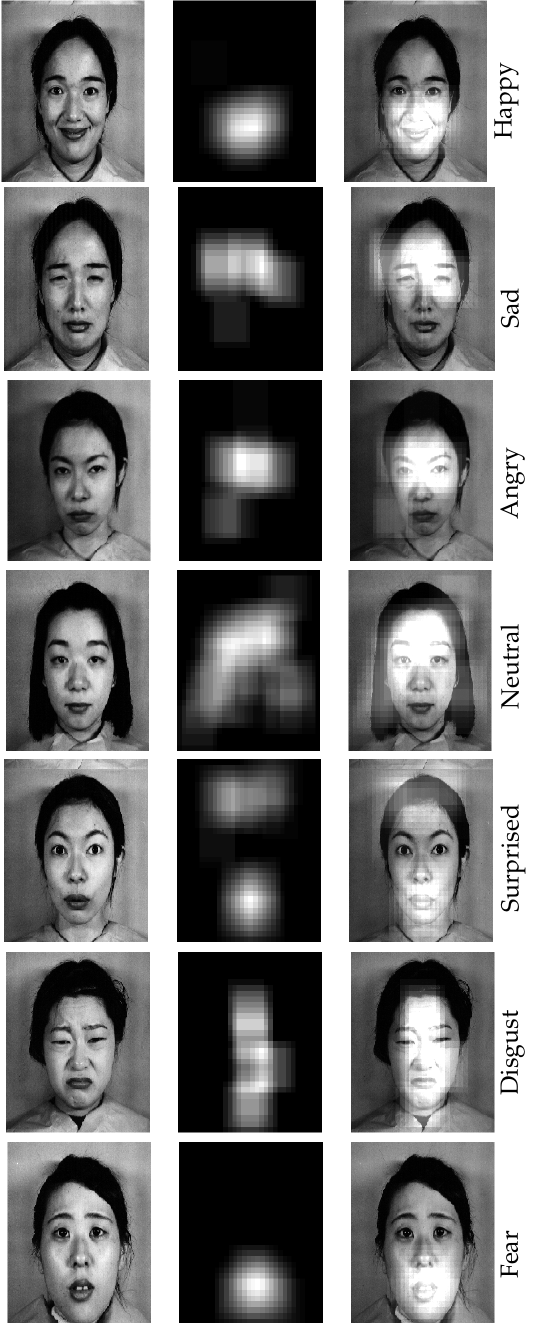
Figure 12. The important regions for detecting different facial expressions. As it can be seen, the saliency maps for happiness, fear, and surprise are sparser than that for the other emotions. It is worth mentioning that different images with the same facial expression could have different saliency maps due to the different gestures and variations in the image. In Figure 13, we show the important regions for three images with a facial expression of “fear”. As seen in this figure, the important regions for these images are very similar when detecting the mouth, but the last one also considers some parts of forehead as impor- tant regions. This could be because of the strong presence of forehead lines, which is not visible in the two other